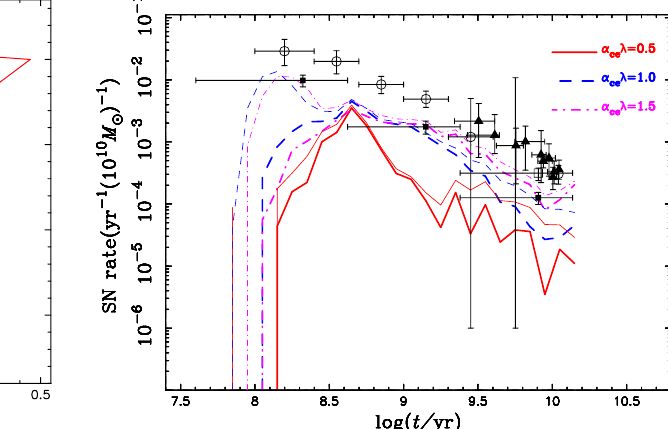
Figure 1. Parameter space of WD+He star systems for the formation of SNe Ia based on the DD model. From Liu et al. (2017).